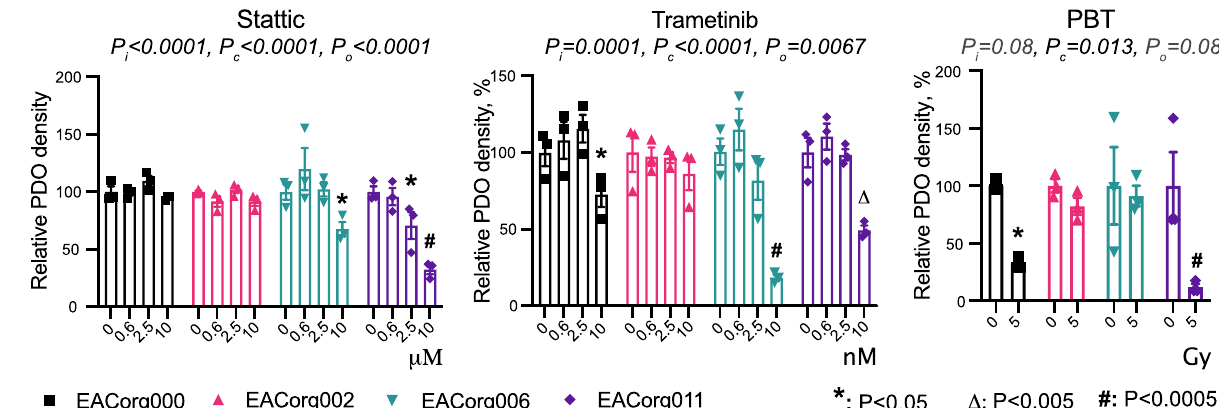
Figure 6. EAC PDOs can be used to identify susceptibilities to new therapeutics. Relative PDO density in response to experimental treatment. 2-way ANOVA parameters: P i = significance of interaction (differential response of organoid lines), P c = significance of concentration/dose, P o = significance of organoid line. Error bars = SEM, * P < 0.05, Δ P < 0.005, # P <